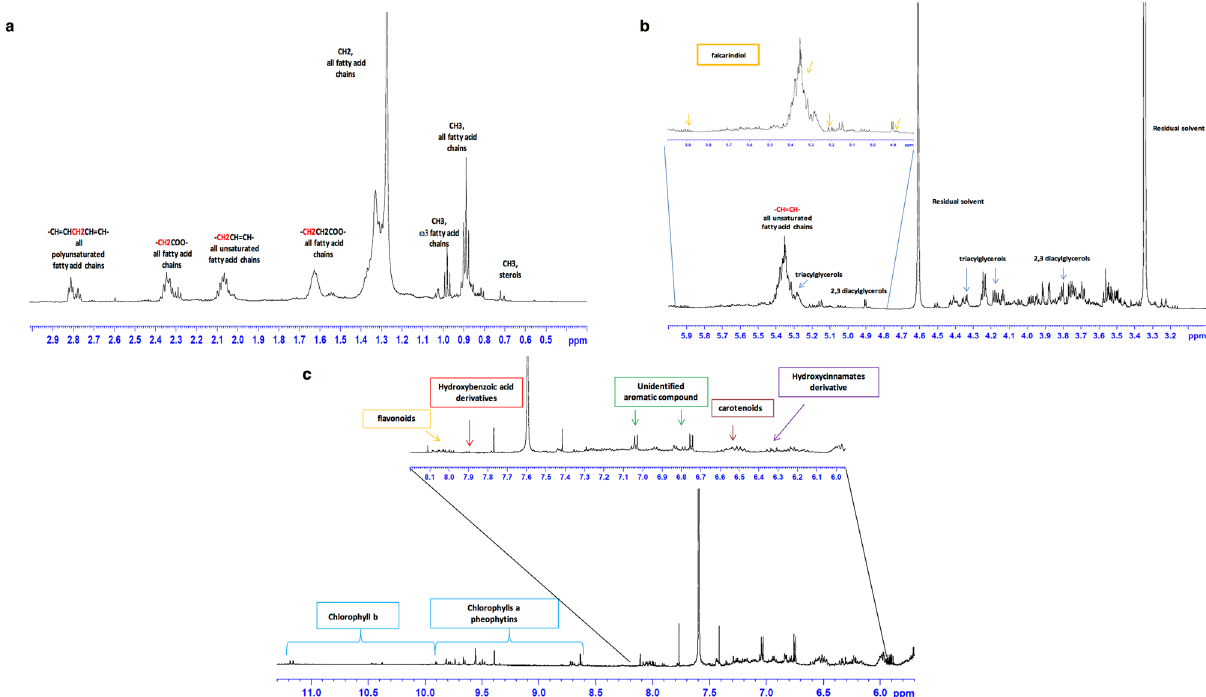
Figure 2. 1 H-NMR typical spectrum (600 MHz, CD 3 OD:CDCl 3 ) of Crithmum maritimum ethyl acetate extract sample in ( a ) high, ( b ) middle, and ( c ) low-frequency regions, showing the main metabolite classes associated with principal